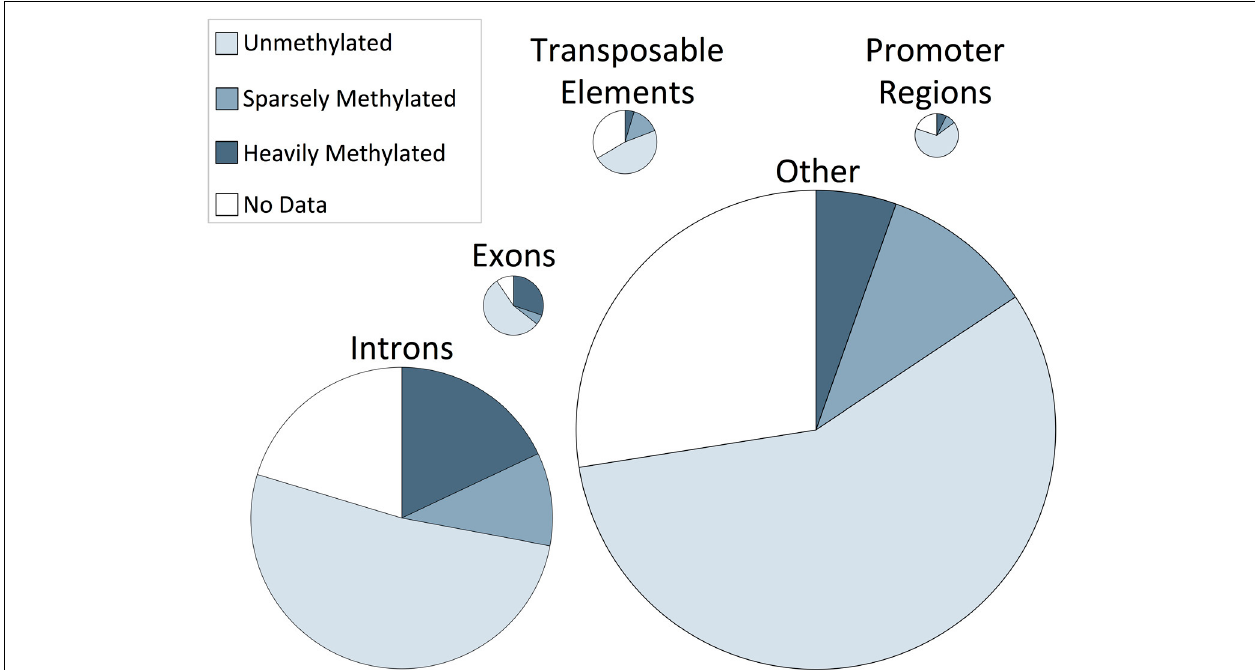
FIGURE 2 | Genome-wide distribution of CpG methylation in C. gigas male gamete tissue within genomic regions. The proportion of CpG unmethylated (ratio = 0), sparsely methylated (ratio between 0 and 0.5), heavily methylated (ratio ≥ 0.5), or CpG